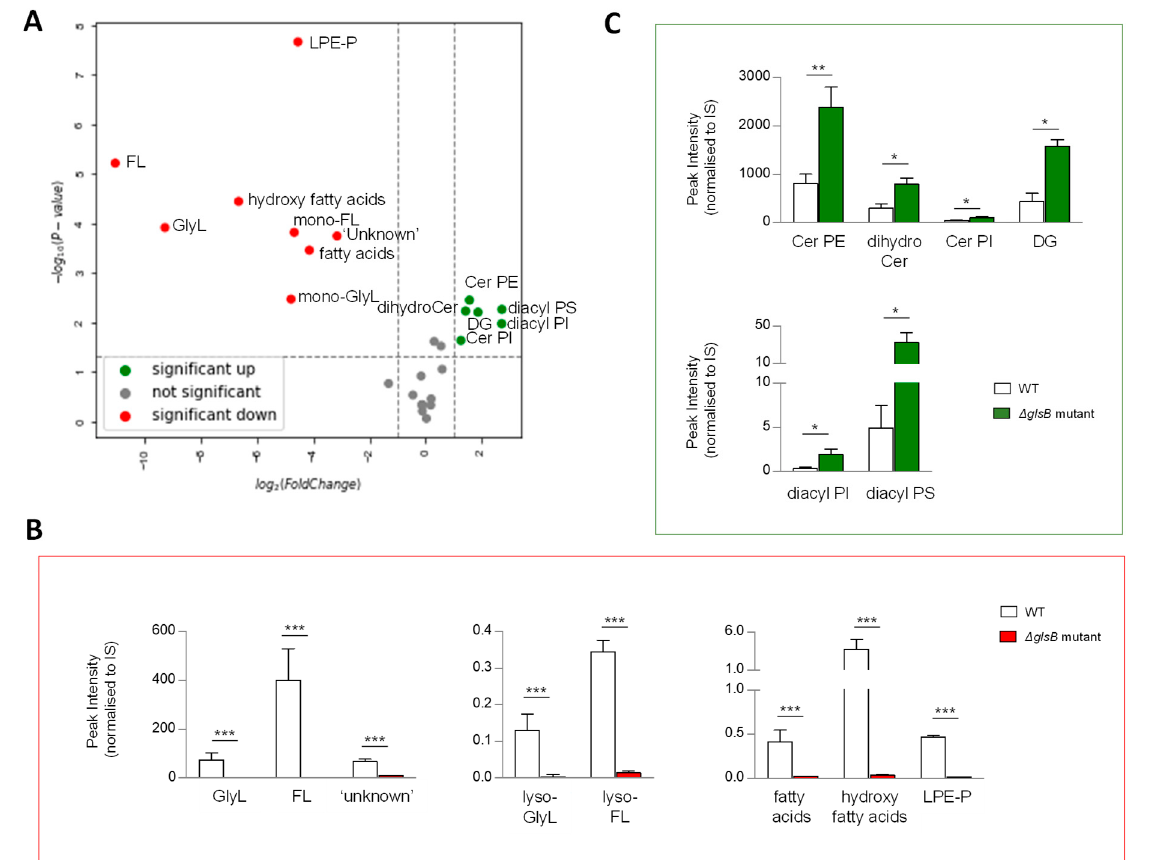
Figure 6. A mutation in glycine lipid biosynthesis ( Δ glsB ) results in changes in the sphingolipid (SP) pool relative to wild type (WT) B. thetaiotaomicron. ( A ) Univariate analyses (volcano plot) reveal significant (fold change >2 and t-test p -value < 0.05) changes to the lipid profile of B. thetaiotaomicron with 8 of the 26 lipid ‘subgroups’ significantly decreased (indicated in red) in the B. thetaiotaomicron Δ glsB mutant relative to the parent WT strain, while 6 were significantly increased (depicted in green) and 12 were either unchanged or not detected (ND) (depicted in grey). ( B ) Δ glsB resulted in complete depletion of Glycine lipids (GlyL) and flavolipins (FL). Other significantly decreased lipids were a series of ‘unknown’ lipids, which we predict as N -acyl amine lipids, fatty acids, hydroxy fatty acids and glycerophosphoethanolamines (PE) plasmalogens (P), (mono-acylated, LPE-P). ( C ) Many SP were significantly increased as a result of glsB mutation; they included dihy- droceramides (dihydroCer), dihydroCer ethanolamines (Cer PE) and dihydroCer inositols (Cer PI). Significant increases were also observed for diacylglycerols (DG), diacyl glycerophosphoinoistols (PI) and diacyl glycerophosphoserines (PS). All data shown are mean values of n = 3 ± standard deviation from the mean (SD). Student T test was applied: *** p < 0.001, ** p < 0.005, * p < 0.05 to log-transformed data prior to univariate analyses. The data shown represent area under the curve, un-transformed peak intensity